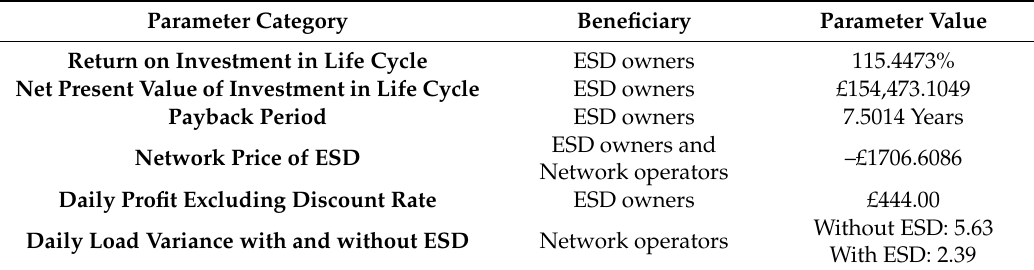
Figure 15. Influence of ESD operation on load demand in a complex system. Table 7. Comparison of parameters in Figure 15.